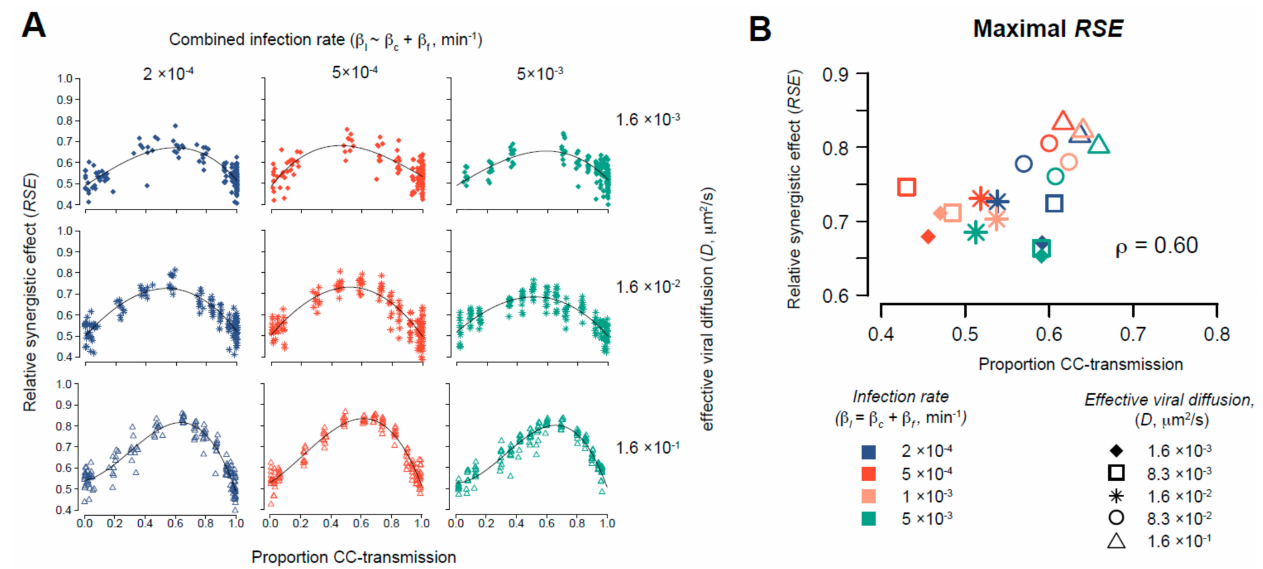
Figure 5. Advantages of combined modes of viral spread: ( A ) Predicted advantage of combined modes of viral spread indicated by the Relative Synergistic Effect ( RSE ) of combined viral spread. The RSE is shown dependent on the proportion of infections by cell-to-cell transmission given different viral diffusion coefficients and infection rates. Individual points indicate the maximal RSE obtained for simulating viral spread in the ABM for a 10-day time course with different combinations of the transmission factors for each transmission mode, β c and β f , defining the combined infection rate β I . Curves show the result of a spline function of third-degree fitted to the individual data. ( B ) Maximal RSE value and proportion of infections due to cell-to-cell transmission at which the fitted curves reached their maximum for different conditions analyzed (( A ), Figure